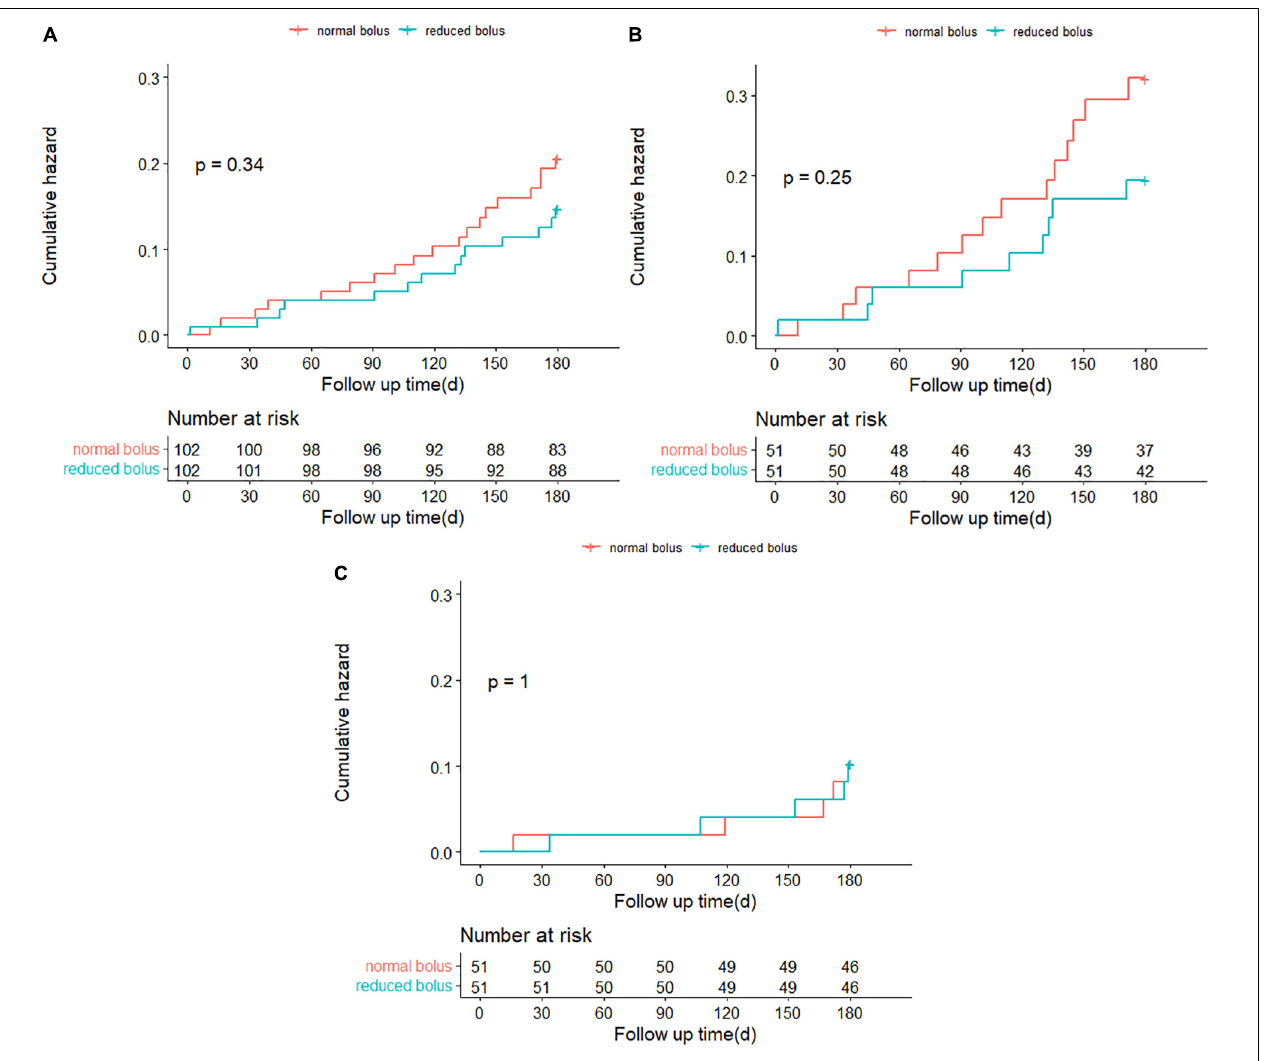
FIGURE 6 | (A) Time-to-event curves for any Bleeding Academic Research Consortium (BARC) bleeding through 6-month follow-up. (B) Time-to-event curves for any BARC bleeding through 6-month follow-up in patients with normal eGFR. (C) Time-to-event curves for any BARC bleeding through 6-month follow-up in patients with abnormal